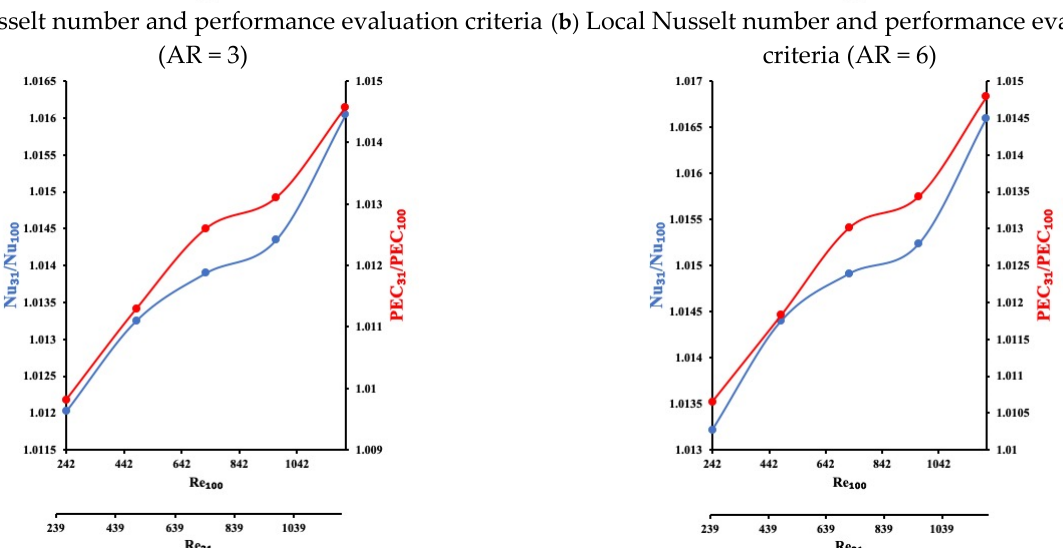
Figure 8. The ratio of local Nusselt number and performance criterion between nanofluid with different nanoparticles diameter.